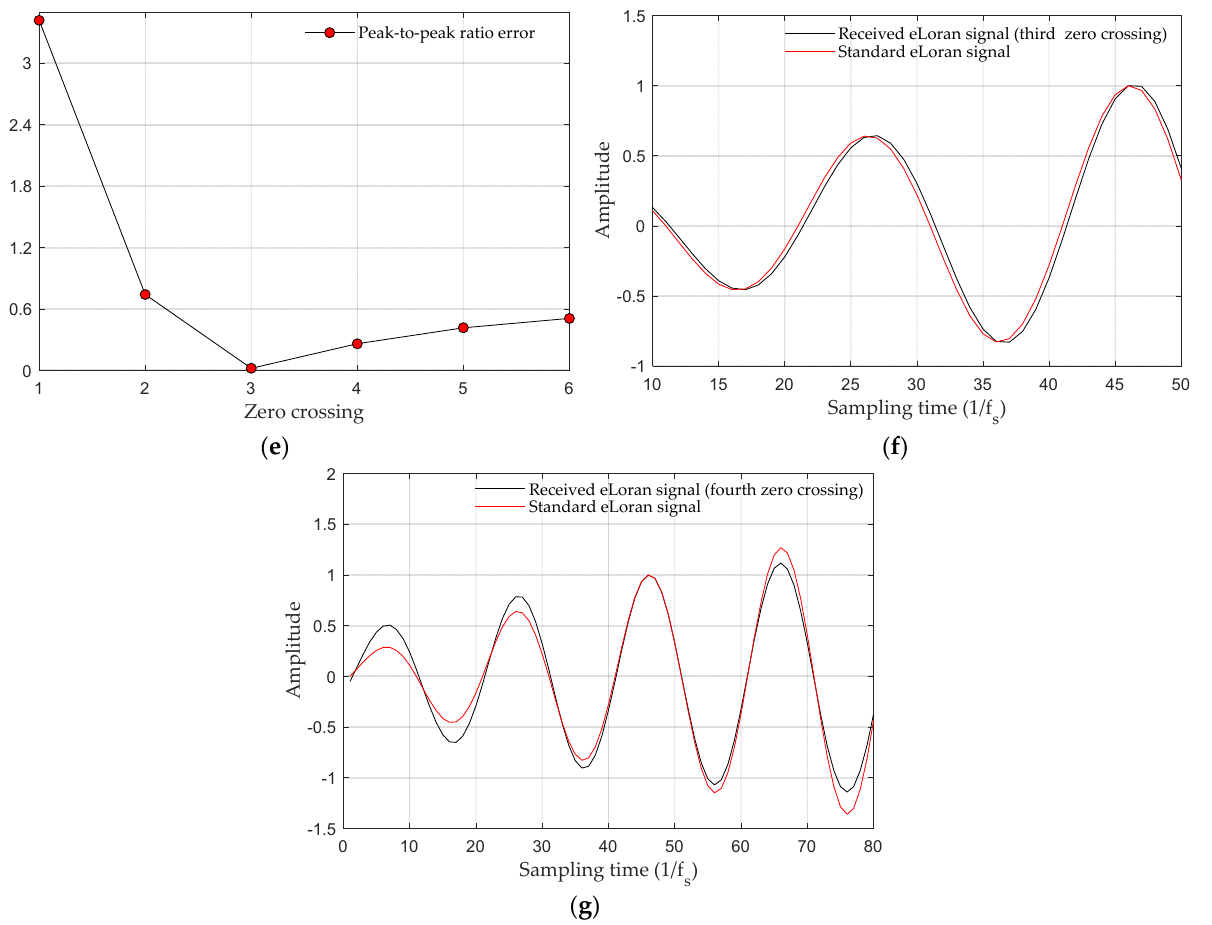
Figure 7. Simulation results of cycle identification: ( a ) the signal generated by the simulation; ( b ) bandpass-filtering result; ( c ) linear digital averaging result; ( d ) spectrum-division result; ( e ) peak- to-peak ratio error; ( f ) third zero-crossing waveform match; ( g ) fourth zero-crossing waveform match.